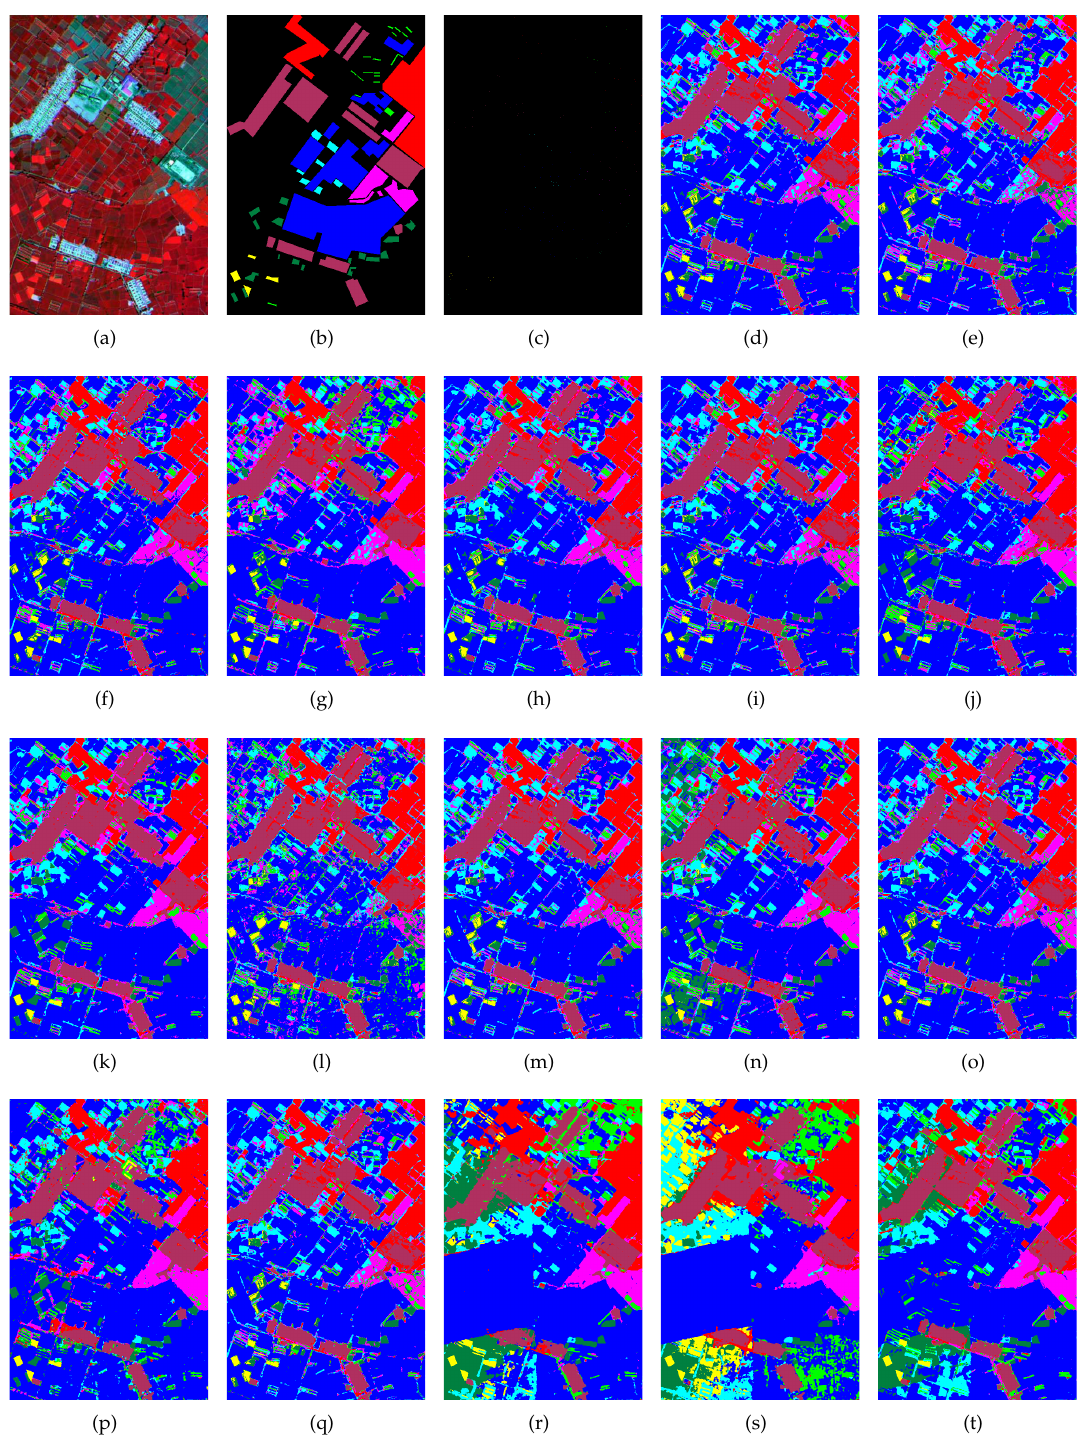
Figure 9. Classification maps of different methods on the Heihe data set. ( a ) False color image; ( b ) Ground truth; ( c ) Training samples; ( d ) RAW; ( e ) PCA; ( f ) NPE; ( g ) LPP; ( h ) LDA; ( i ) MMC; ( j ) MFA; ( k ) NWFE; ( l ) SPP; ( m ) SDE; ( n ) SME; ( o ) SMML; ( p ) MMDA; ( q ) DSSM; ( r ) LPNPE; ( s ) WSSGLDA; ( t )